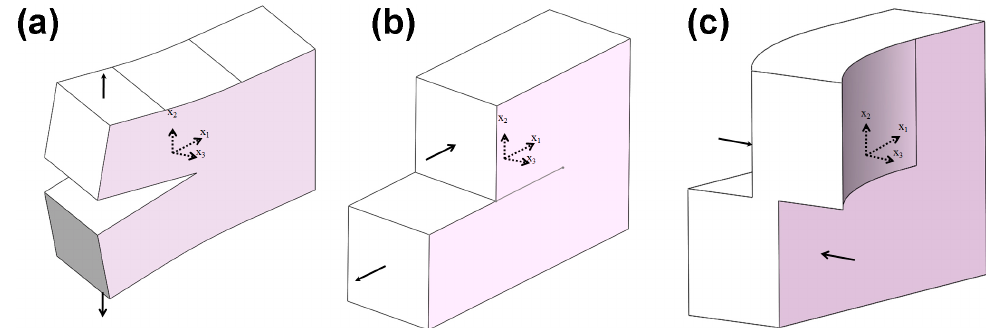
Figure 8. Schematic of the basic fracture modes under three-dimensional cracks: ( a ) Mode I (opening); ( b ) Mode II (shearing); ( c ) Mode III (tearing).